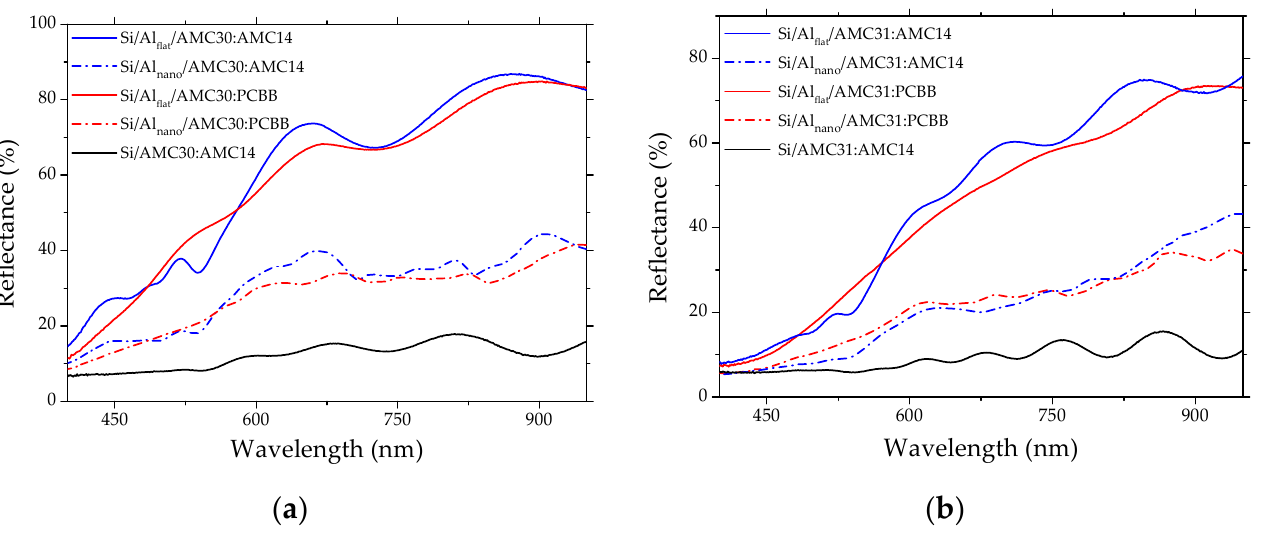
Figure 5. Reflectance spectra of the mixed layers with AMC 30 donor and PCBB or AMC14 acceptor deposited on Al flat and Al nano ( a ). Reflectance spectra of the mixed layers with AMC 31 donor and PCBB or AMC14 acceptor deposited on Al flat and Al nano ( b ). Si/AMC30:AMC14 and Si/AMC31:AMC14 are reference samples. The reflectance of the mixed layer containing AMC31 (Figure 5b) was lower than the reflectance of the mixed layer containing AMC30. The reflectance was between 50 and 75 % when the mixed layer was deposited on Al flat , and between 25 and 40% when the mixed layer was deposited on Al nano , for wavelengths over 600 nm. The mixed layer containing AMC14 deposited on Al flat showed larger oscillations compared to the layer containing PCBB. The nano-patterning of Al introduced a more regular periodicity of the